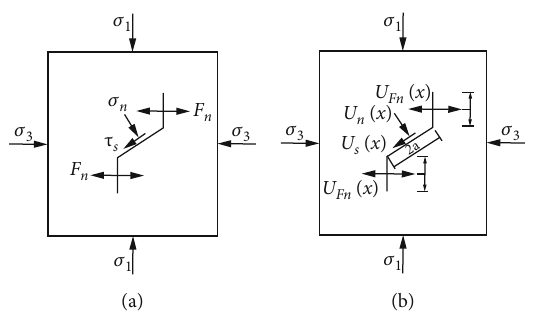
Figure 4: Sketch of the mechanical analysis of wing cracks in the compression-shear state: (a) stress state; (b) deformation